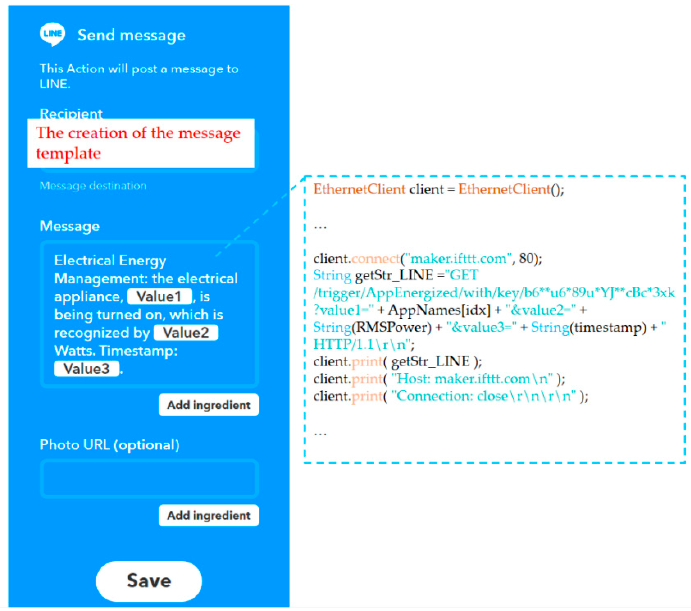
Figure 13. Illustration of the creation of an If-This-Then-That (IFTTT) rule with Webhooks in this Figure 13. experiment.